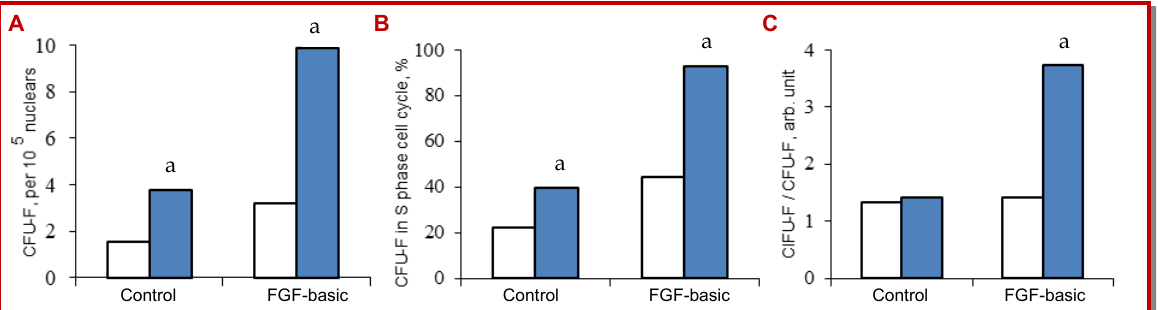
Figure 3: Effects of the PKA inhibitor on the number of CFU-F in wound surface (A), proliferative activity (B) and these cells differ- entiation index (C) in the cell culture of the bone marrow without FGF-basic (control) and with FGF-basic without signaling mole- cule inhibitor (white bars) and when the inhibitor (blue bars) are added to the medium; Used the Mann-Whitney test (*p<0.05 in comparison with the